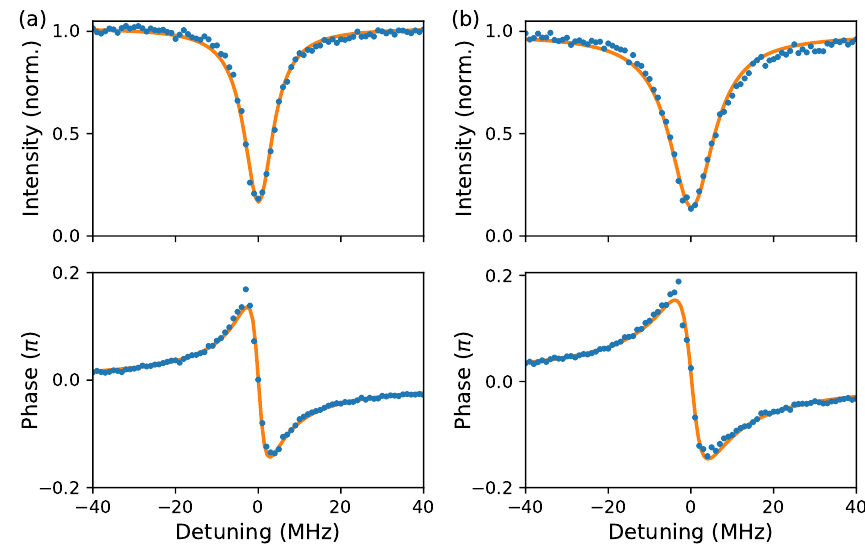
Figure 3. ( a ) Measured intensity and phase profiles (blue dots) of the resonance at 0.5561 THz at 7ppmv with the corresponding fit (orange solid lines). ( b ) The same resonance at 120ppmv water vapour concentration. Both measurements are recorded with similar coupling strength to ease